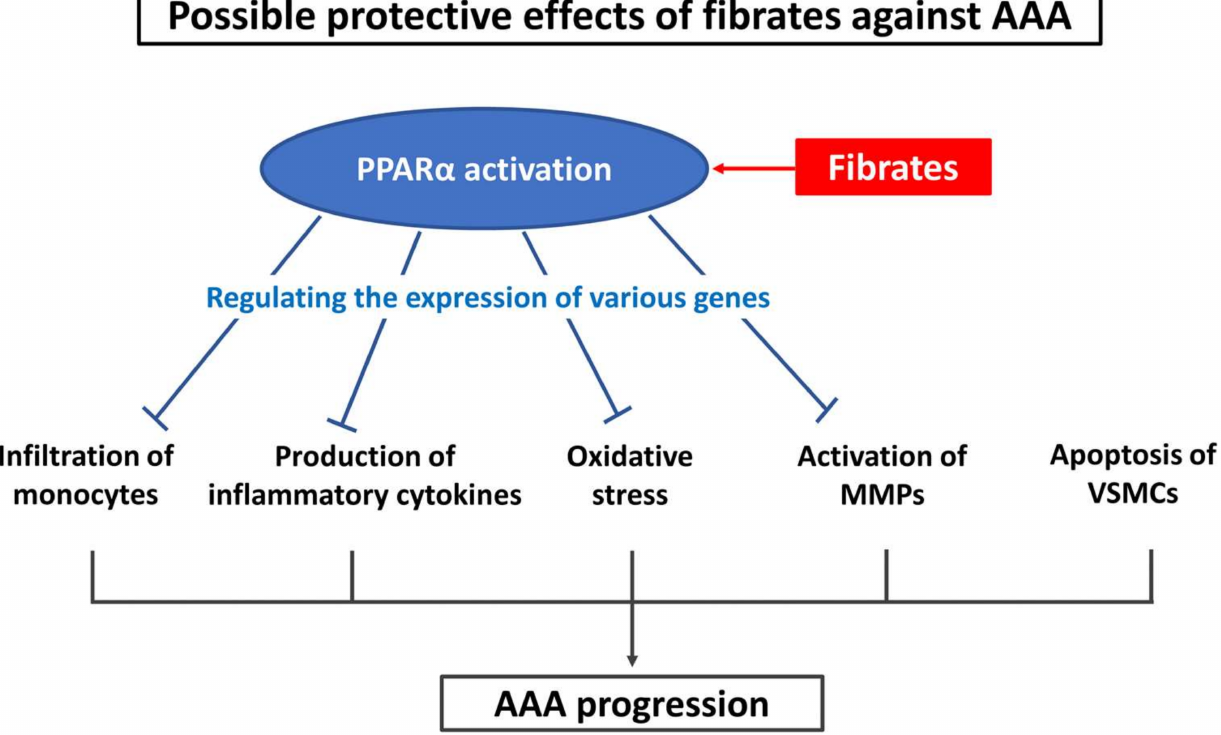
Figure 1. Possible protective effects of fibrates against AAA. AAA—abdominal aortic aneurysm; MMPs—matrix metalloproteinases; PPAR α —peroxisome proliferator-activated receptor alpha; VSMCs—vascular smooth muscle